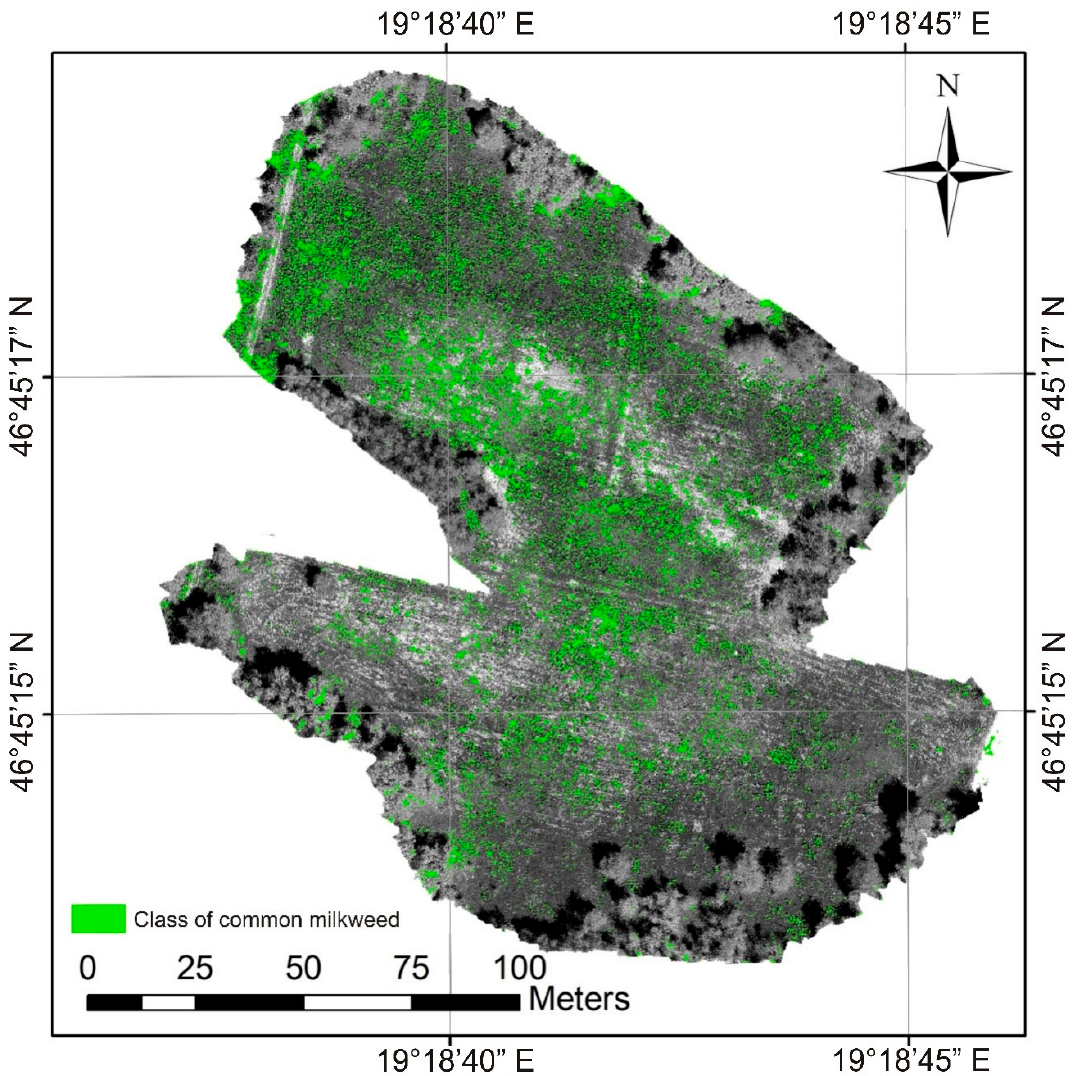
Figure 6. Results of ANN classification on the whole study area. Here, the green color represents the areas infected by common milkweed.